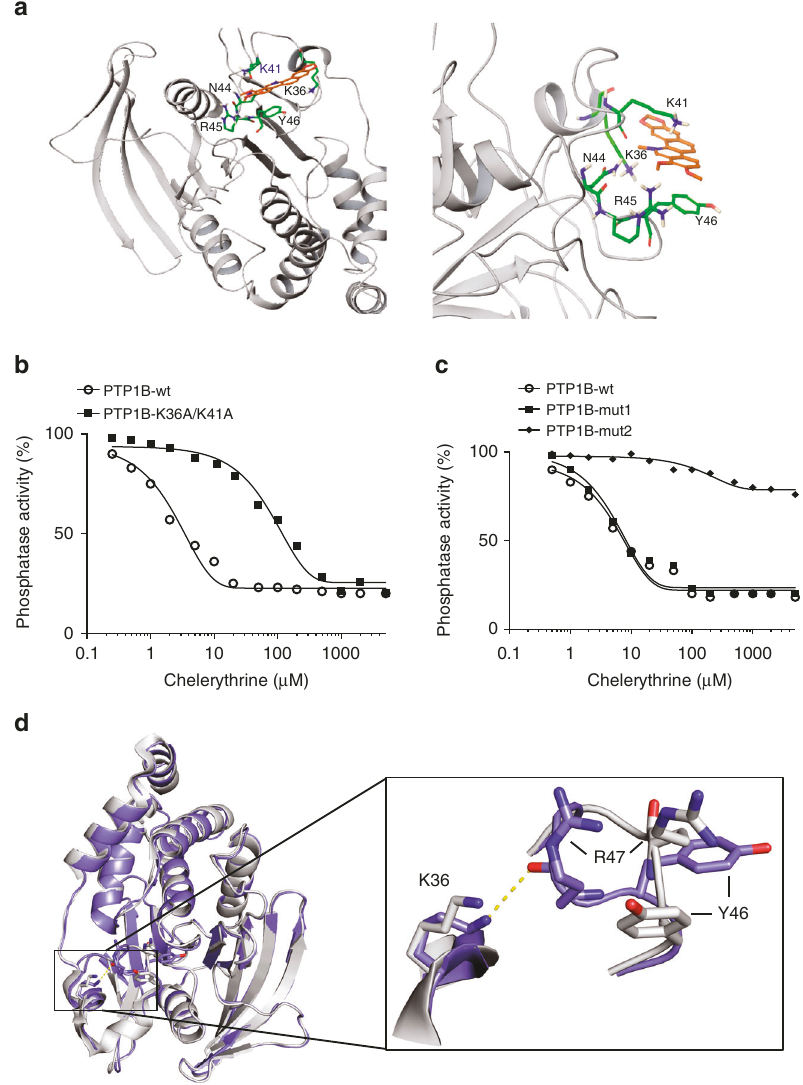
Fig. 5 Chelerythrine and scFv45 inhibit reactivation of PTP1B-OX by a similar mechanism. a Molecular modeling of chelerythrine binding to PTP1B-OX, with critical residues for the interaction highlighted on the right. b Oxidized PTP1B-wt (circle), PTP1B-K36A/K41A (square) were incubated with increasing concentrations of chelerythrine (0 – 10 mM) and phosphatase activity was measured using DiFMUP as substrate in the presence of the reducing agent TCEP (5 mM). c Oxidized PTP1B-wt (circle), PTP1B-mut1 (square), or PTP1B-mut2 (diamond) were incubated with increasing concentrations of chelerythrine (0 – 10 mM) and phosphatase activity was measured using DiFMUP as substrate in the presence of the reducing agent TCEP (5 mM). Individual data points represent the mean obtained from three separate experiments ( n = 3; b , c ). d Overlay of crystal structures of the reduced (blue) and oxidized (gray) form of PTP1B. The inset shows the change in the position of residues K36, Y46, and